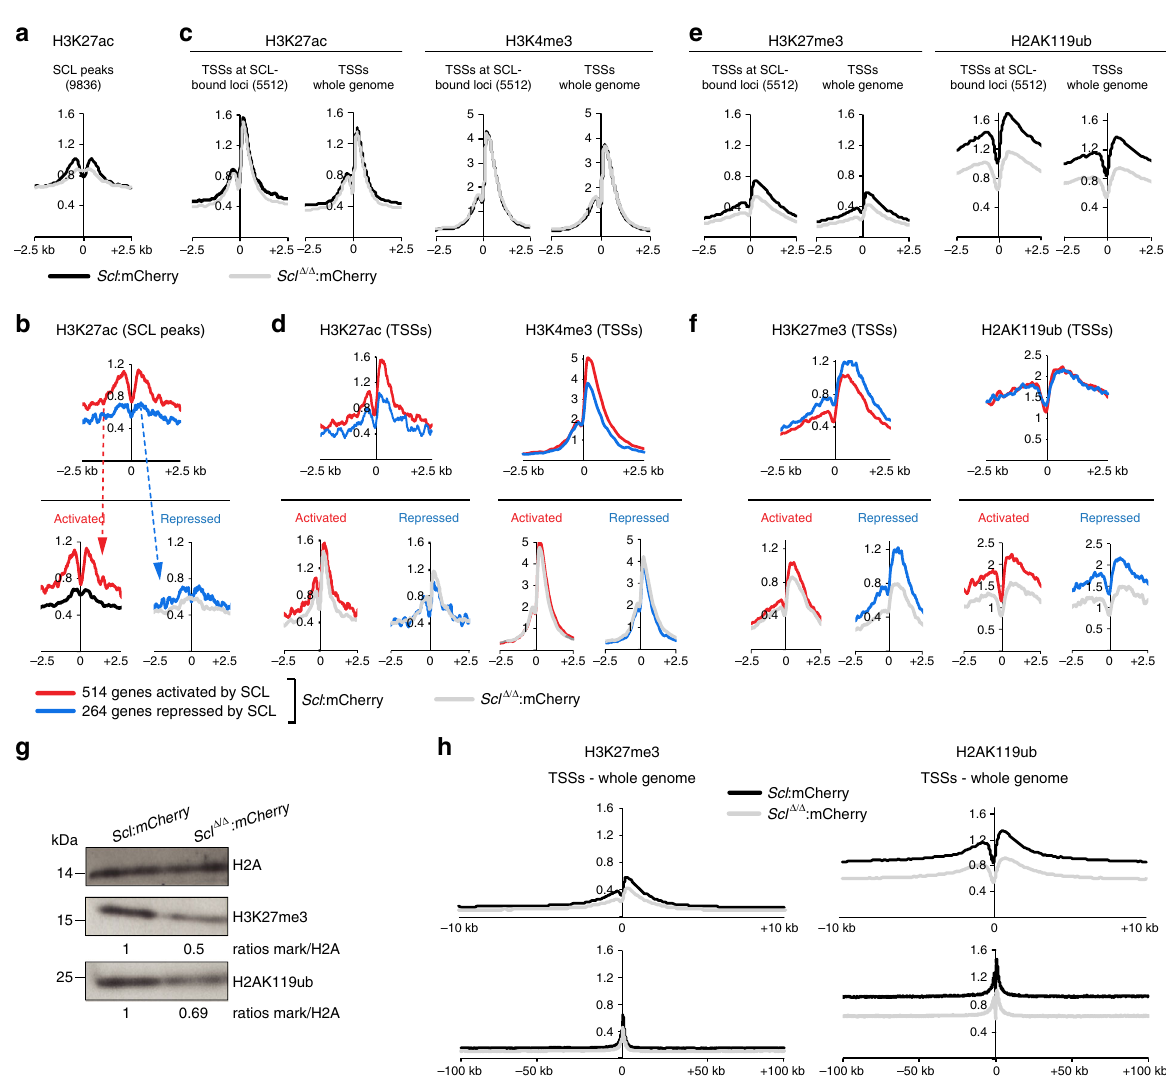
Fig. 5 SCL loss-of-function affects the epigenetic landscape of blood-fated progenitors. a , c , e Distribution plots of normalised histone mark ChIP-seq signals in mCherry + cells puri fi ed from Scl:mCherry and Scl Δ / Δ :mCherry day 4 EBs. Signals are sorted on SCL ChIP-seq peaks ( a H3K27ac only), TSSs of SCL- bound 5512 genes and TSSs across the whole genome, ±2.5 kb, ( c activation associated-marks H3K27ac and H3K4me3; e repression associated-marks H3K27me3 and H2AK119ub). b , d , f Distribution plots of normalised histone mark ChIP-seq signals in mCherry + cells puri fi ed from Scl:mCherry and Scl Δ / Δ : mCherry day 4 EBs on SCL direct DEGs (514 activated genes (red) and 264 repressed genes (blue)). Signals are sorted on SCL ChIP-seq peaks associated to SCL direct DEGs ( b H3K27ac only) and TSSs of SCL direct DEGs, ± 2.5 kb ( d , activation associated-marks; f repression associated-marks). Top, Scl: mCherry EB cells; bottom, Scl:mCherry and Scl Δ / Δ :mCherry EB cells. g Western blot analysis of H3K27me3 and H2AK119ub levels in mCherry + cells puri fi ed from Scl:mCherry and Scl Δ / Δ :mCherry day 4 EBs. H2A, loading control. Relative levels of each histone mark over H2A in mutant versus control cells are indicated. n = 2. h Distribution plots of normalised H3K27me3 and H2AK119ub ChIP-seq signals in mCherry + cells puri fi ed from Scl:mCherry and Scl Δ / Δ : mCherry day 4 EBs. Signals are sorted on TSSs across the whole genome; top, ±10 kb, bottom, ±100 kb. See also Supplementary Figs. 4, 8